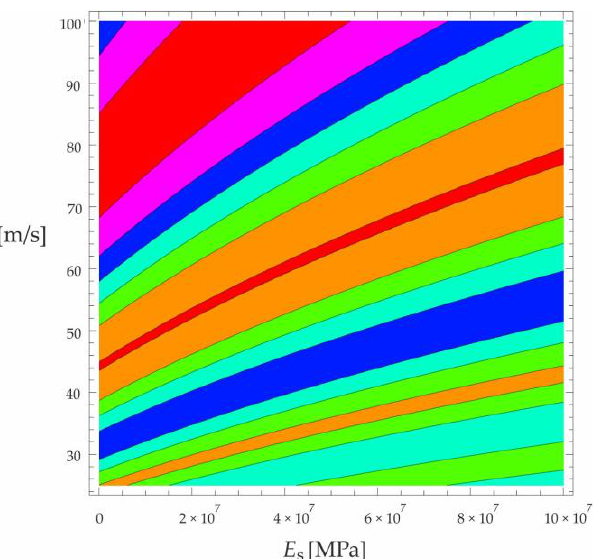
Figure 8. Effect of moving force velocity and a foundation’s Young’s modulus on the deflection of the midpoint of a simply supported beam under forced vibration — contour map corresponding to the diagram in Figure 7.